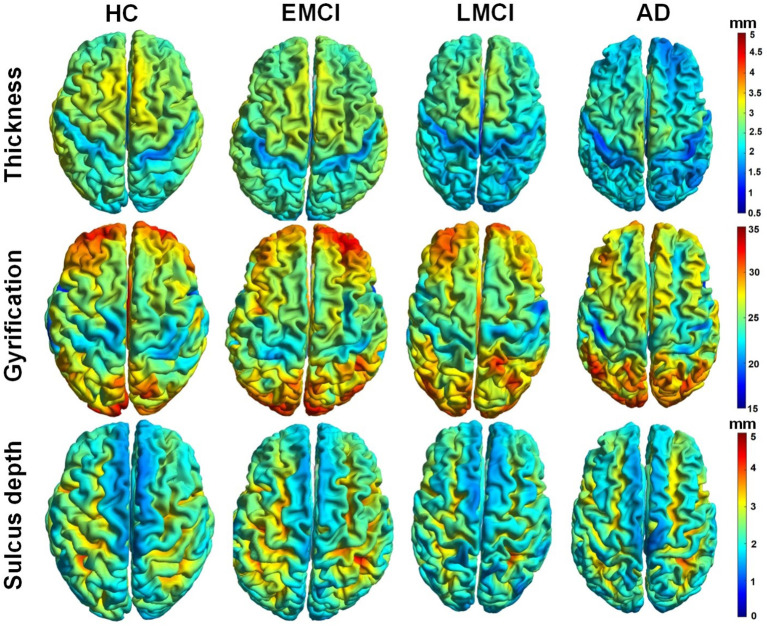
Whole-brain mapping of surface thickness, gyrification index (GI), and sulcus depth maps estimated using CAT12 toolbox. From left to right, each column represents a subject in control, early mild cognitive impairment (EMCI), late MCI (LMCI), and AD groups, respectively.